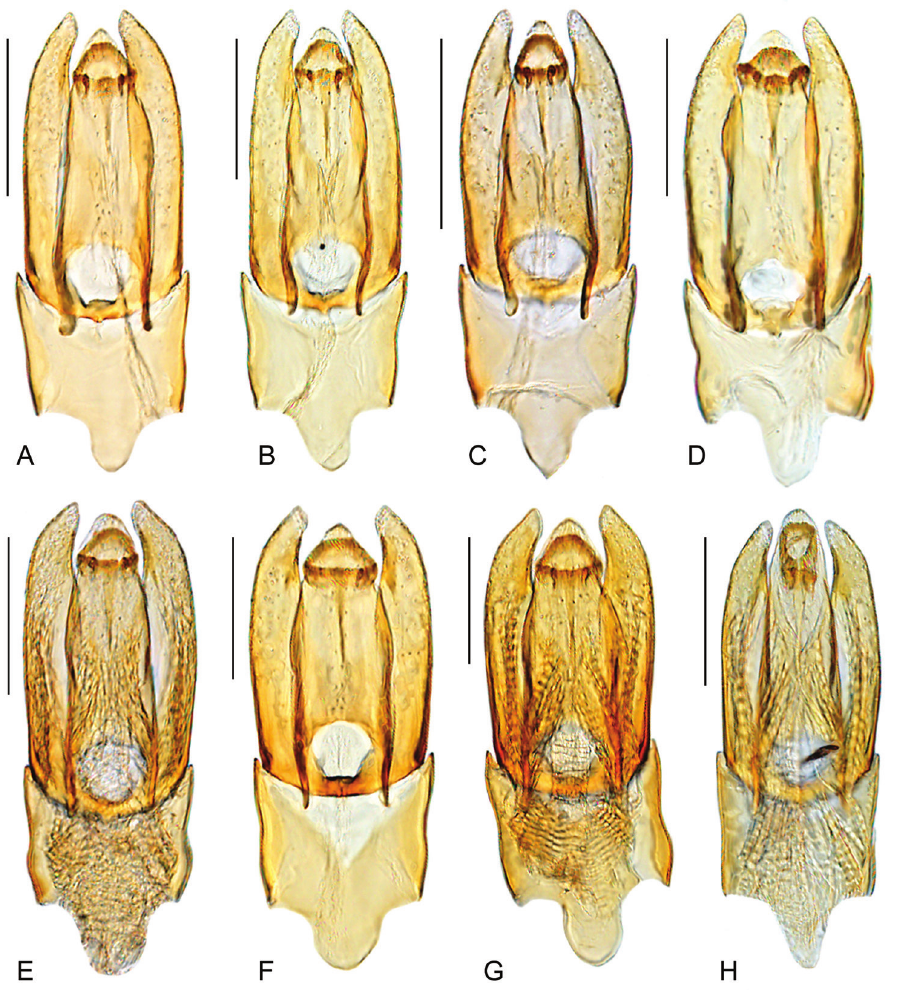
Figure 8. Aedeagus of Quadriops similaris : A SURINAME: Marowijne: Palumeu [SUR1F99 164] B GUYANA: Iwokrama Forest [GUY1BF01 005] C BRASIL: Manaus D SURINAME: Marowijne: Palumeu [SUR1F99 182] E FRENCH GUIANA: Roura [FG1AB97 027] F GUYANA: Iwokrama For- est [GUY1BF01 105] G FRENCH GUIANA: Cayenne: [FG1AB97 171] H SURINAME: Saramacca [SUR1F99 070]. Scale bar 0.1